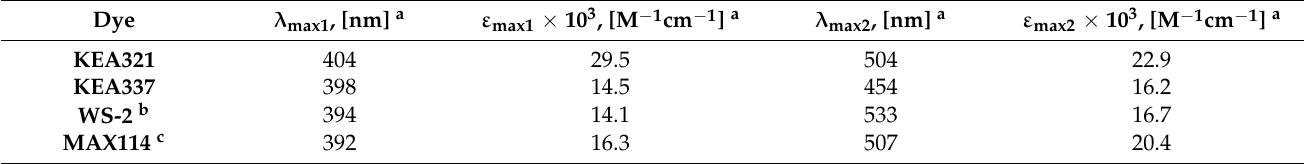
Figure 3. Structures of the dyes MAX114 and WS-2 .